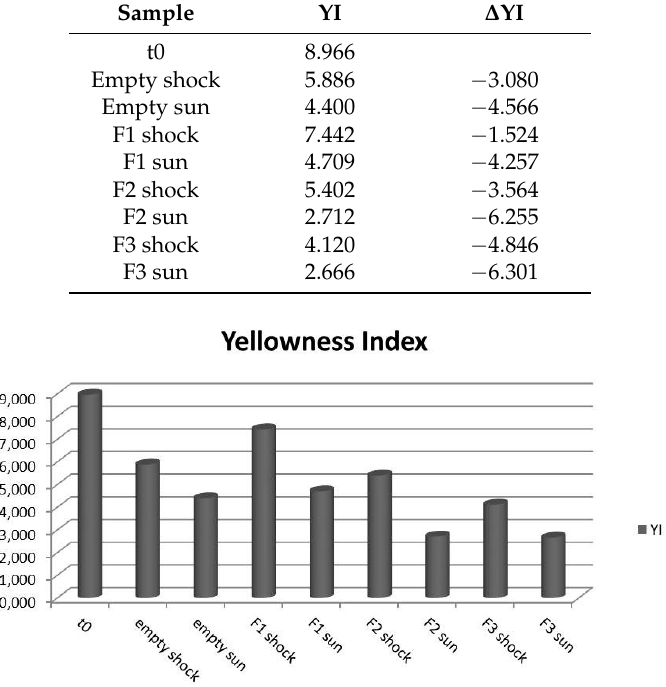
Figure 3. Yellowness index values obtained for the packaging.